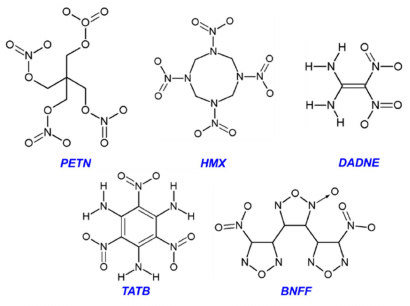
Figure 1. Schematic of PETN, HMX, DADNE, TATB, and BNFF molecular